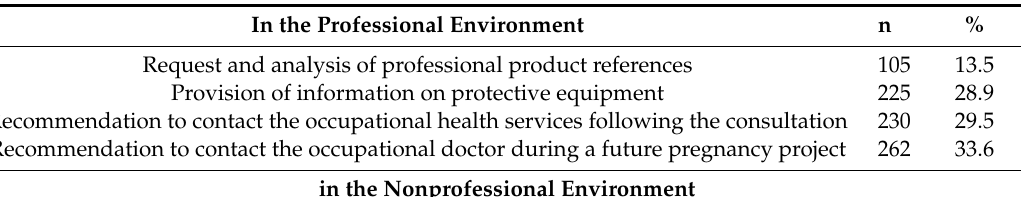
Table 7. Preventive measures proposed to patients or spouses seen at the ARTEMIS Center from 16 February 2016 to 2 May 2019 (n = 779